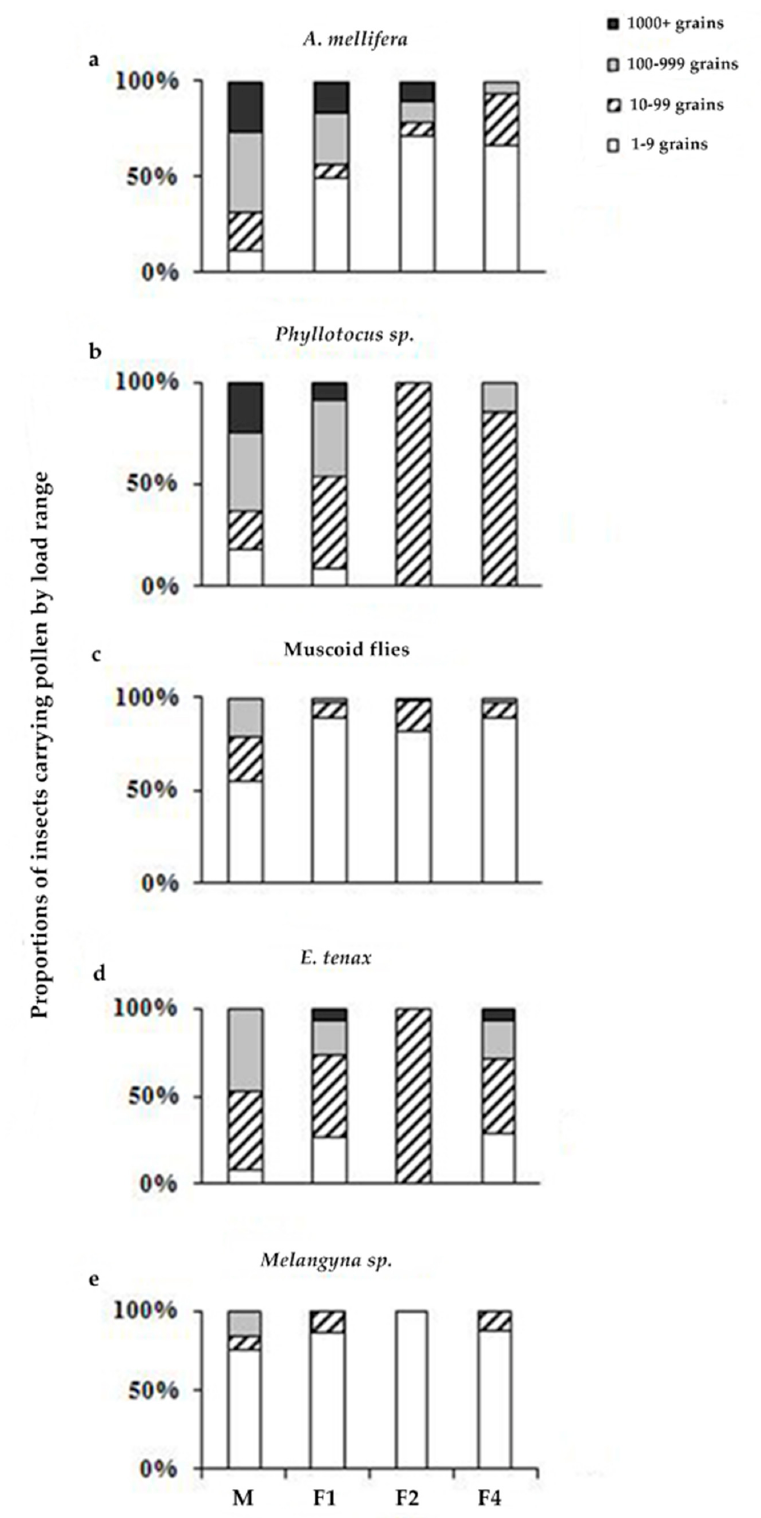
Figure 4. Pollen grains collected from insects in a carrot crop in the first season. M = male-fertile row, F1 = cytoplasmically male-sterile row adjacent to row M, and F2 and F4 rows are respectively two and four rows away from row M. Pollen loads are grouped into four categories: 0–9 grains, 10–99 grains, 100–999 grains, and 1000+ grains. Sample sizes from ( a – e ): n = 133, 35, 243, 56, and 36 respectively.